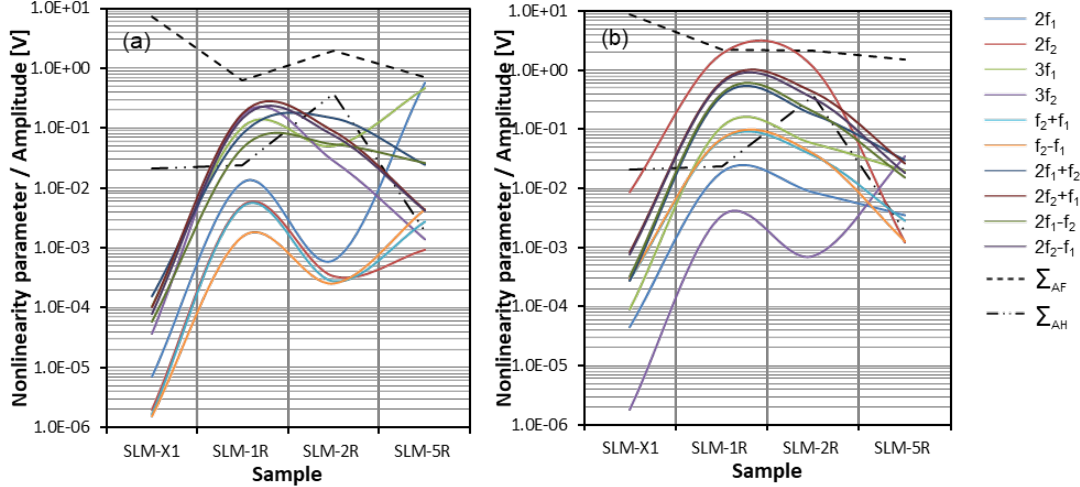
Figure 25. Nonlinearity parameter: ( a ) f 1 = 3 MHz, f 2 = 5 MHz, α = 60°; ( b ) f 1 = 4 MHz, f 2 = 5 MHz, α = 60°.